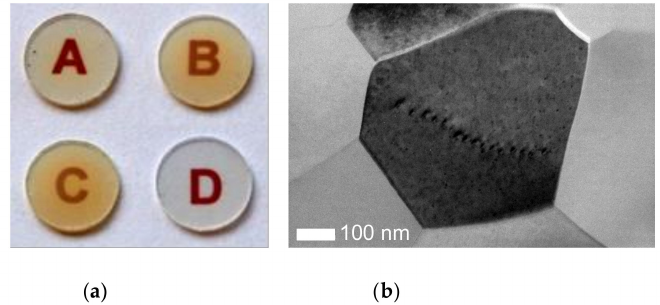
Figure 8. ( a ) Photos of SPS sintered Mg-doped alumina after post sintering thermal treatment at 1150 ◦ C in air for 30 min. The uniaxial sintering pressure of 100 MPa was applied for ( A – C ) the whole sintering cycle and ( D ) at soak temperature only. The heating rates were for ( A and D ) 100 ◦ C / min, ( B ) 233 ◦ C / min and ( C ) 350 ◦ C / min. It can be observed that a single-step pressure cycle generates a yellowish coloration which increases with increasing heating rate. A two-step pressure profile avoids the coloration which can be explained in a similar way to that of the study on transparent MgAl 2 O 4 [47]. ( b ) Dislocation walls observed in sample C in TEM, prior to thermal